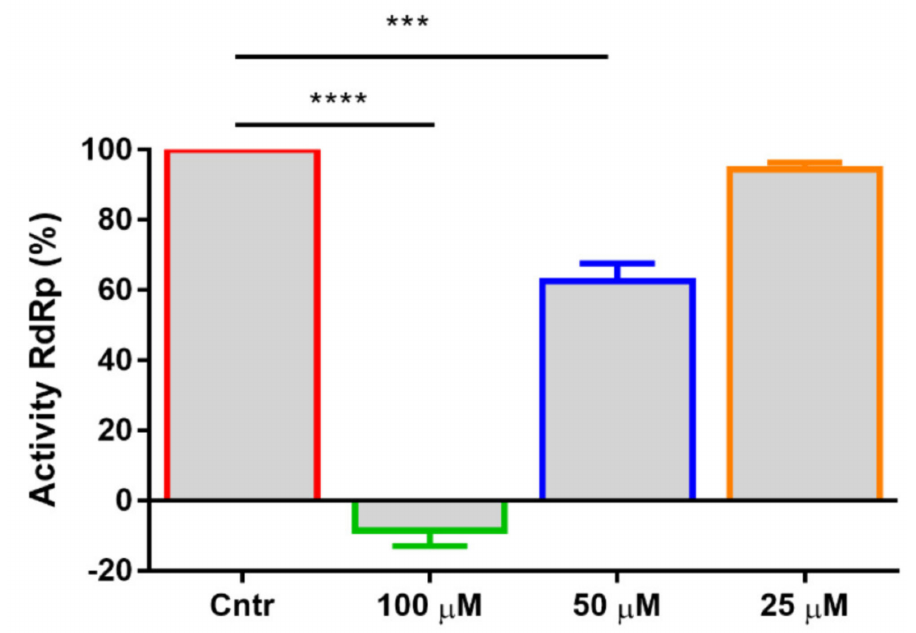
Figure 6. Uracil Derivative 876 Inhibit the Transcriptional Activity of SARS-CoV-2 RNA-dependent RNA polymerase. Transcriptional inhibition plot of the SARS-CoV-2 replication complex treated with 876 or PBS (control) ( n = 3). Results are representative mean ± SEM. One-way ANOVA with Tukey’s post hoc test: *** p < 0.001 and **** p <